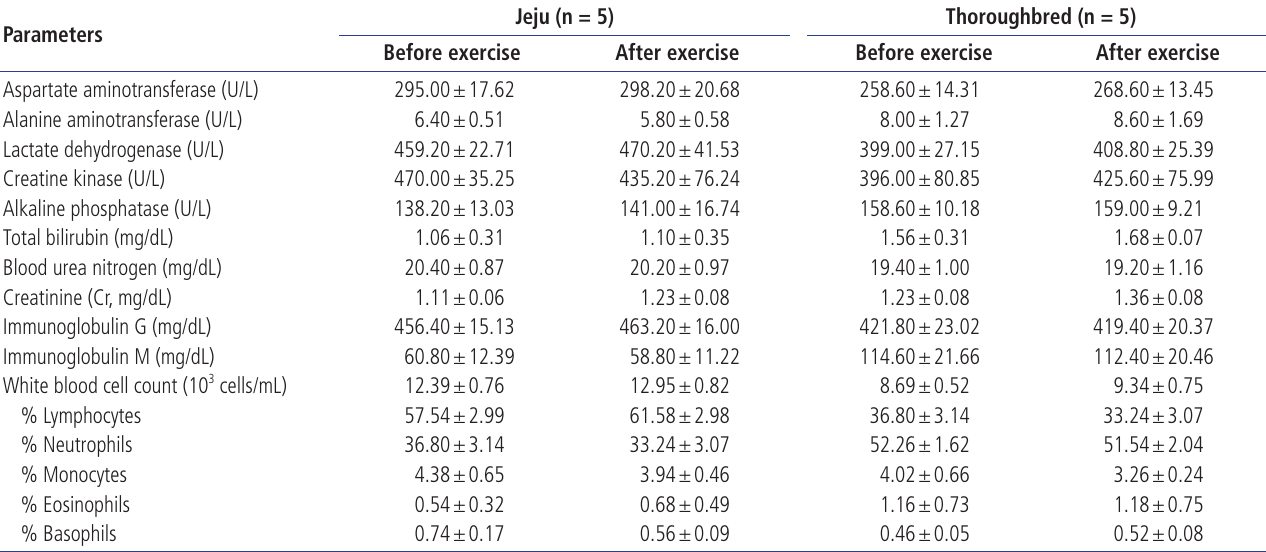
Table 2. Biochemical analysis, immunological analysis, white blood cell count and proportion of blood immune cells of Jeju and Thoroughbred horses before and after 30 minute exercise